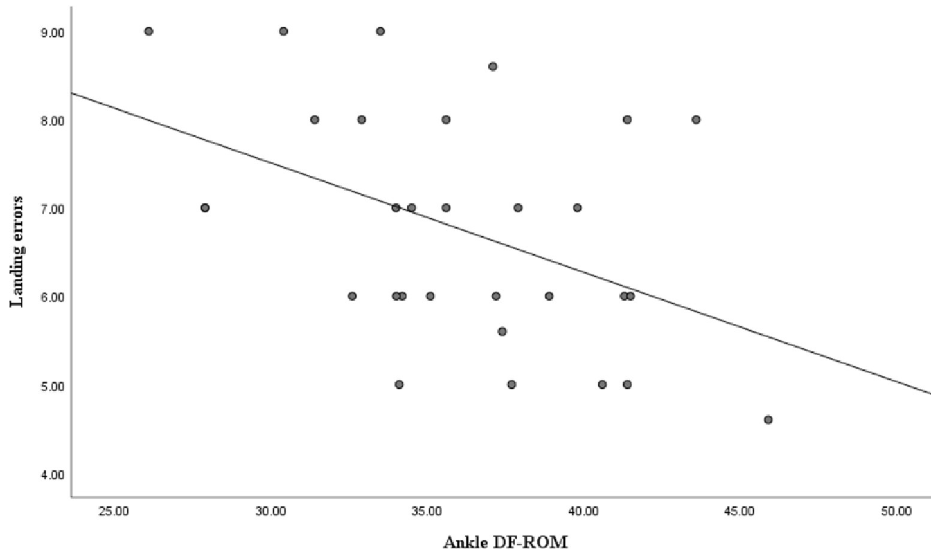
Fig 3. Scatter diagram of ankle dorsiflexion range of motion (DF-ROM) and landing errors.